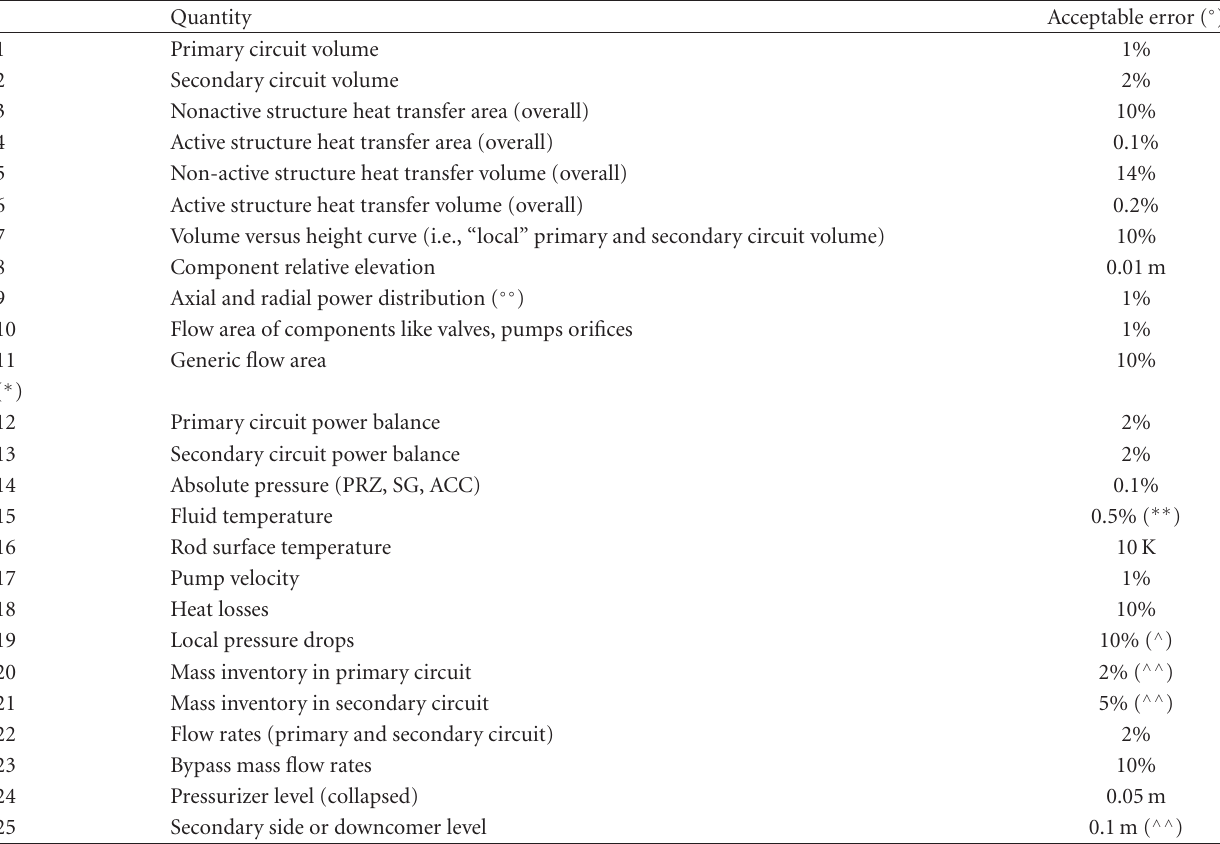
Table 1: Parameters and acceptable errors for the nodalization qualification at “steady-state”